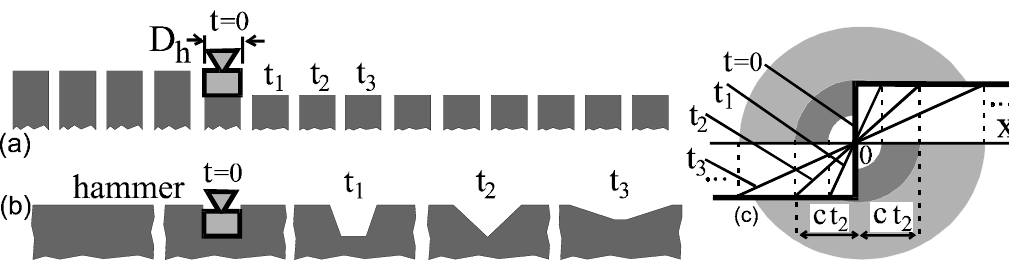
Figure 3. On the nonequivalence of control of velocity and control of pressure: "plasticity" in the boundary problems without